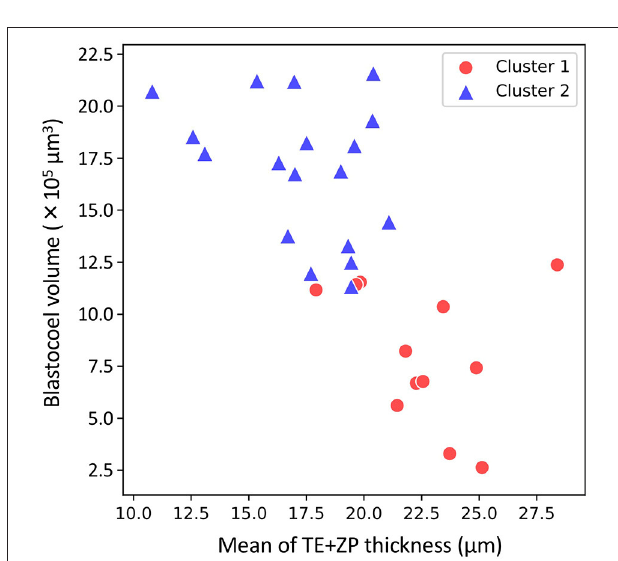
FIGURE 11 | Two-dimensional plots profiled based on the mean of trophectoderm (TE) + zona pellucida (ZP) thickness and blastocoel volume evaluated from the optical coherence tomography (OCT)-scanned 3D images of bovine blastocysts (Cluster 1: red circle, Cluster 2: blue triangle; pregnancy: n = 15, non-pregnancy: n =